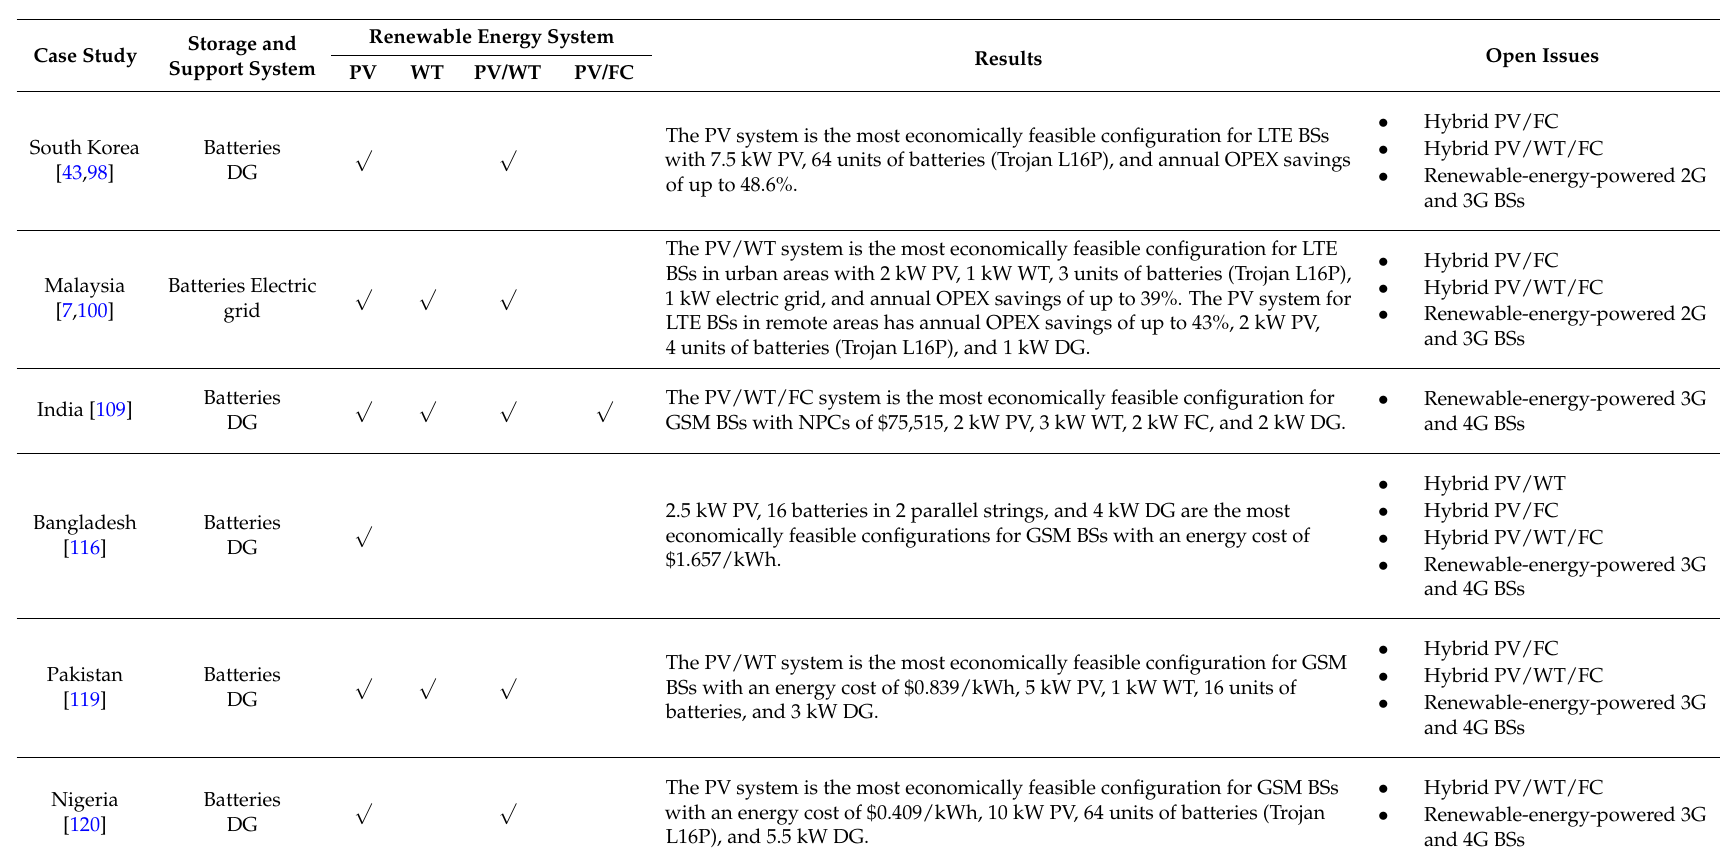
Table 4. Case studies of enabling green cellular BS and open